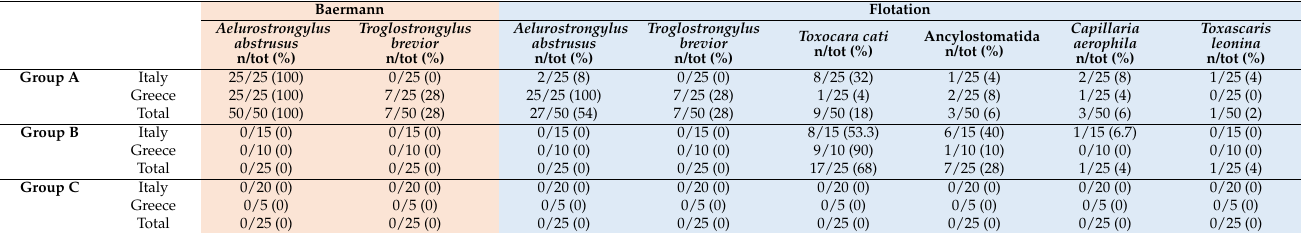
Table 1. Number, provenance and copromicroscopic findings of cats enrolled in the present